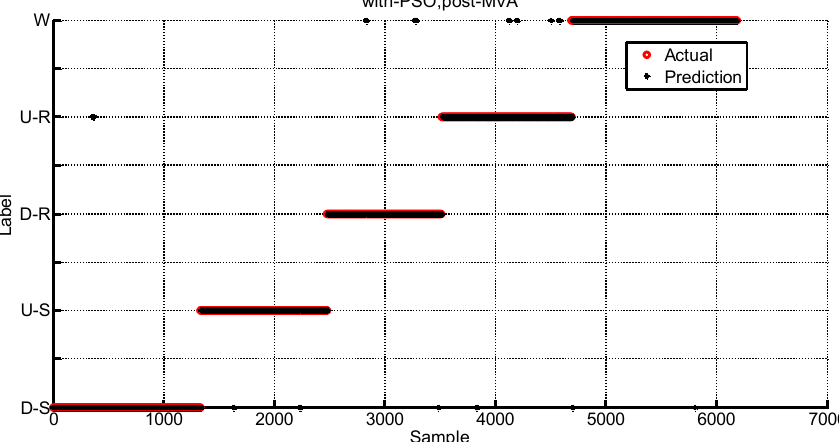
( a ) comparison between pre-MVA and post-MVA under PSO; ( b ) Comparison between without-PSO and with-PSO under MVA.